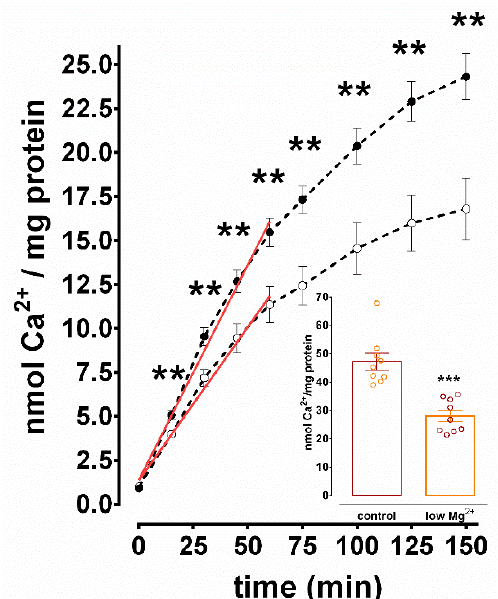
Figure 2. Inhibition of Ca 2 + uptake in mixed hippocampal culture homogenates exposed to low Mg 2 + media for 3 h. Homogenates were isolated acutely from N + G cultures incubated in either control (closed circles) or low Mg 2 + solution (open circles) for 3 h and standard Ca 2 + uptake reactions were performed as described under Materials and Methods. Two-tailed unpaired t -test was used to compare each time point of Ca 2 + uptake in control to low Mg 2 + homogenates (** p ≤ 0.008, all time points ≥ 15 min, n = 10 for all). Red lines represent linear regression slopes of the data points from 5 s to 60 min. Figure 2 (inset): Inhibition of Ca 2 + uptake in mixed hippocampal culture homogenates from neurons subjected to electrophysiological monitoring during treatment. Activity was determined after 150 min of Ca 2 + uptake following 3 h of incubation in either control or low Mg 2 + solution. *** p < 0.0001, n = 9 each, two-tailed unpaired t -test.